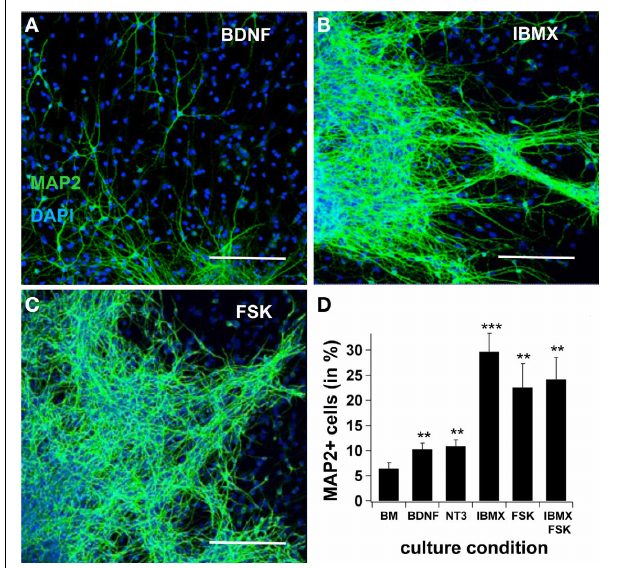
FIGURE 1 | cAMP induces neuronal differentiation. In (A) , (B) and (C) , confocal pictures showing MAP2ab-positivity in cultures maintained in BDNF, IBMX, and Forskolin after 7 days, with pictures taken at the border of the spheres. In (D) , quantification of MAP2 + -cells after 7 days in basal medium, BDNF alone, IBMX, Forskolin and IBMX and Forskolin. The highest yield of neuronal cells was observed in IBMX, and adding Forskolin did not increase the yield of differentiated cells. Green is AlexaFluor488. Scale bar 150 μ